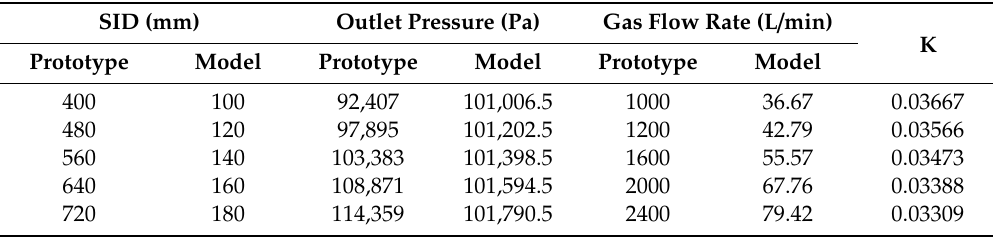
Table 2. The conversion of gas flow rate between prototype and mold with di ff erent Snorkel immersion depths (SIDs).